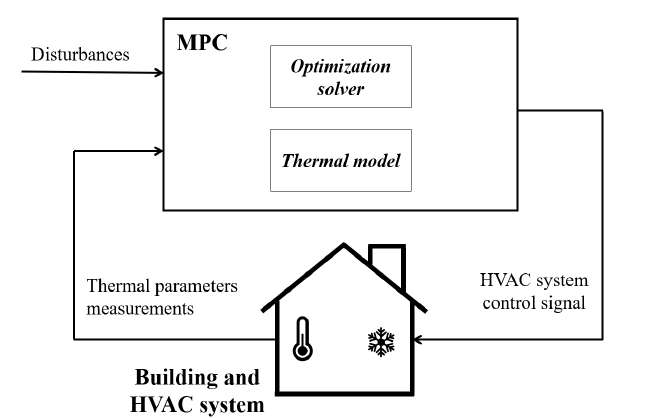
Figure 2. The proposed framework of MPC integrating the thermal model of the indoor